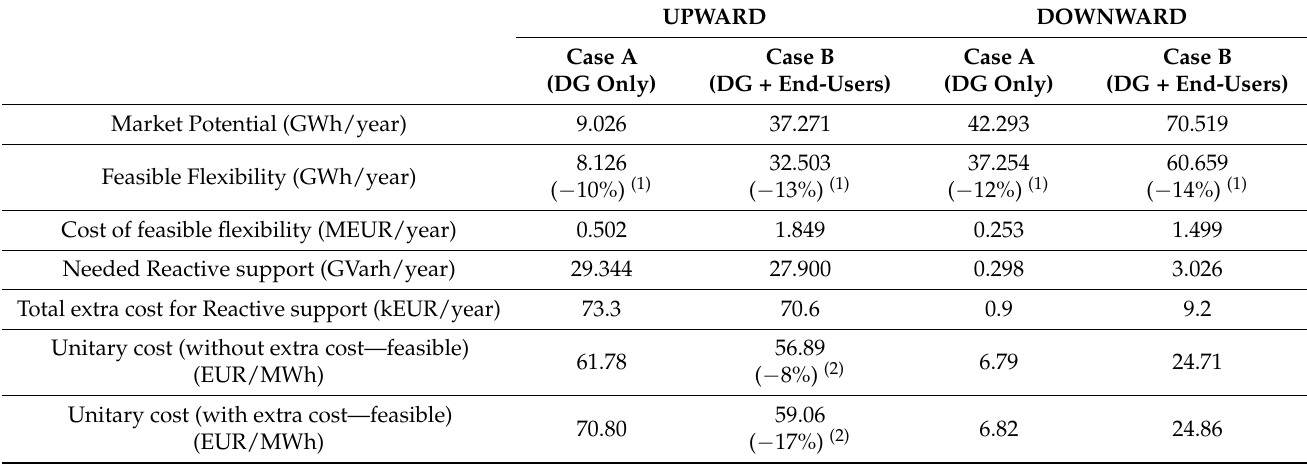
Table 4. Flexibility quantities for the whole substation adopted as Case Study (Figure 2).